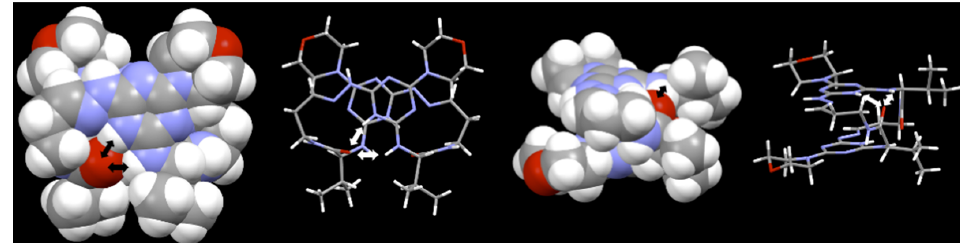
Figure 1. The solid-state structure of the valine macrocycle. Arrows indicate hydrogen bonding interactions wherein the carbonyl from one subunit engages in hydrogen bonding with the protonated triazine of the other.